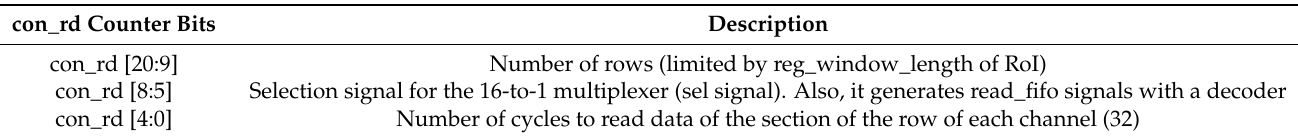
Table 4. Bit description of con_rd signal.